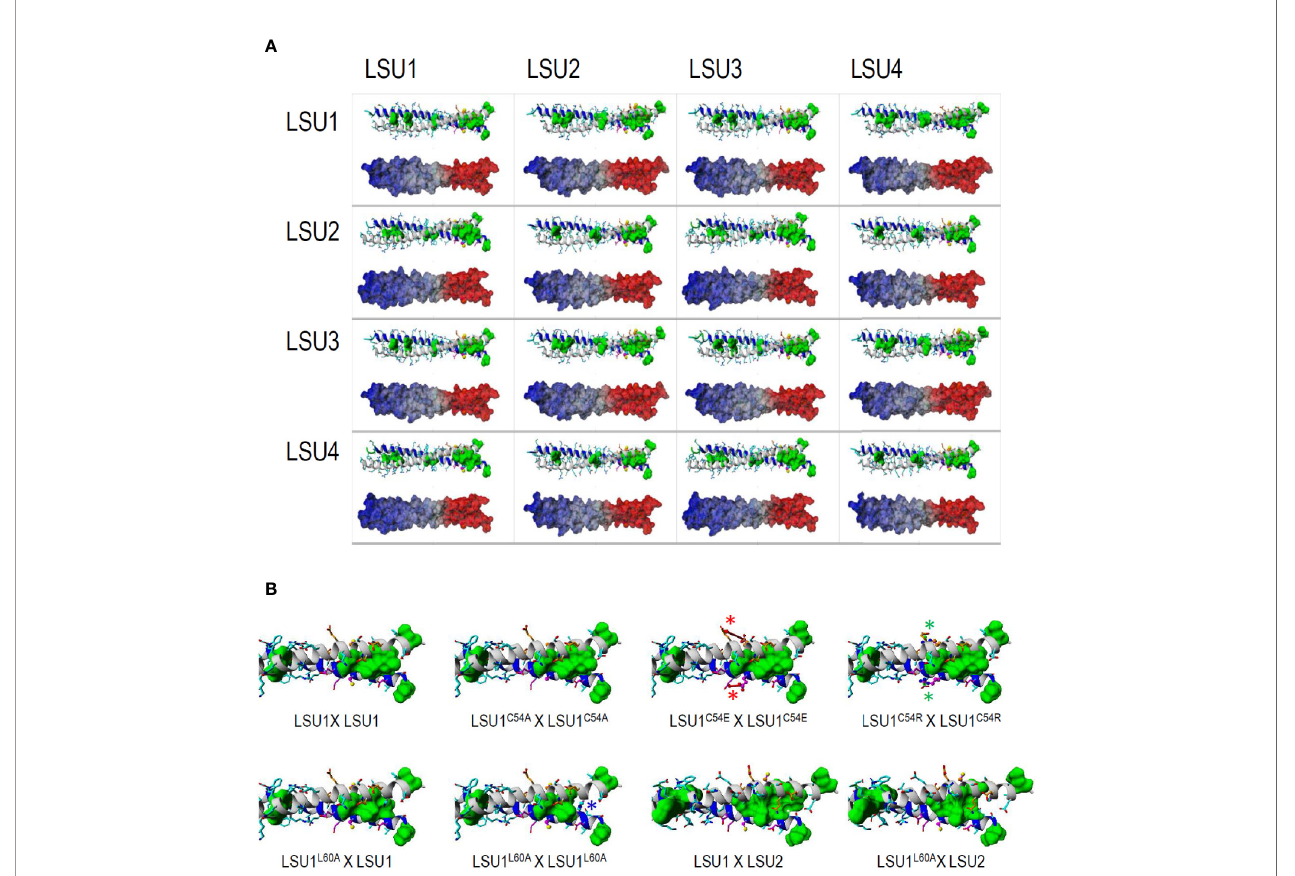
FIGURE 3 | The structures of coiled-coil fragments of the most probable dimers modelled for all 16 possible LSU – LSU pairs (A) and the C-terminal part of the coiled coil for the dimeric structures formed by the LSU1 mutants (B) . (A) According to in silico predictions of the coiled-coil regions, protein fragments covering residues 7 – 65 were modeled. In each inset, the ribbon structure with the side chains — all leucines are marked by green surfaces — is shown above the alternative model demonstrating the distribution of electrostatic potential at the dimer molecular surface; regions of positive and negative potentials are marked in red and blue, respectively. (B) C-terminal part of the coiled coil for the dimeric structures of LSU. C54A replacement remains neutral for the coiled coil formation, while the electrostatic interactions of E54/R54 with the proximal E51 destabilize (red arrows and asterisks) or stabilize (green arrows and asterisks) helical structure, respectively, affecting the stability of the dimer. L60A replacement destroys the leucine-zipper structure in the LSU1 L60A – LSU1 L60A homodimer (blue arrow and asterisk in place of green region), consequently destabilizing the homodimer. In the heterodimers formed by this mutant with LSU1 and LSU2, the leucine-zipper is